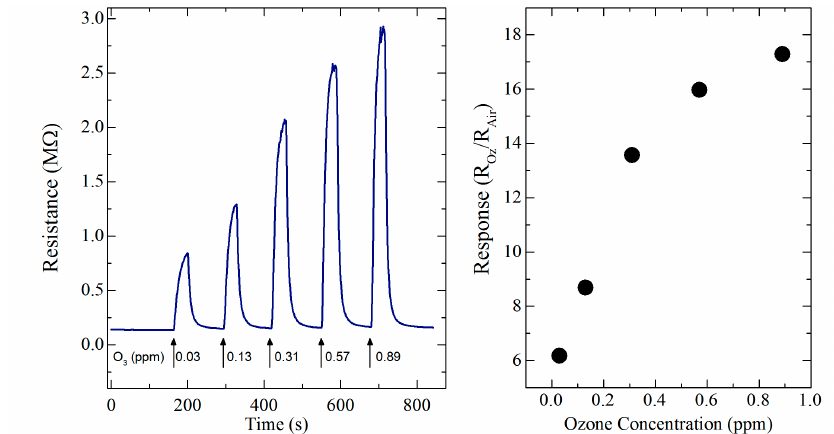
Figure 3. Change in resistance of the ZnO material deposited with30 W and exposed at different O 3 concentrations during 30 s ( left ). Response of the sensor in function of ozone concentration ( right